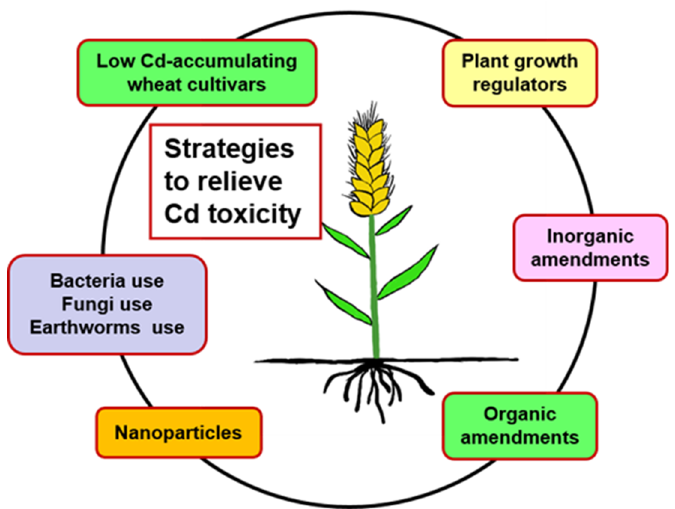
Figure 5. Strategies applied for relieving Cd toxicity in wheat.